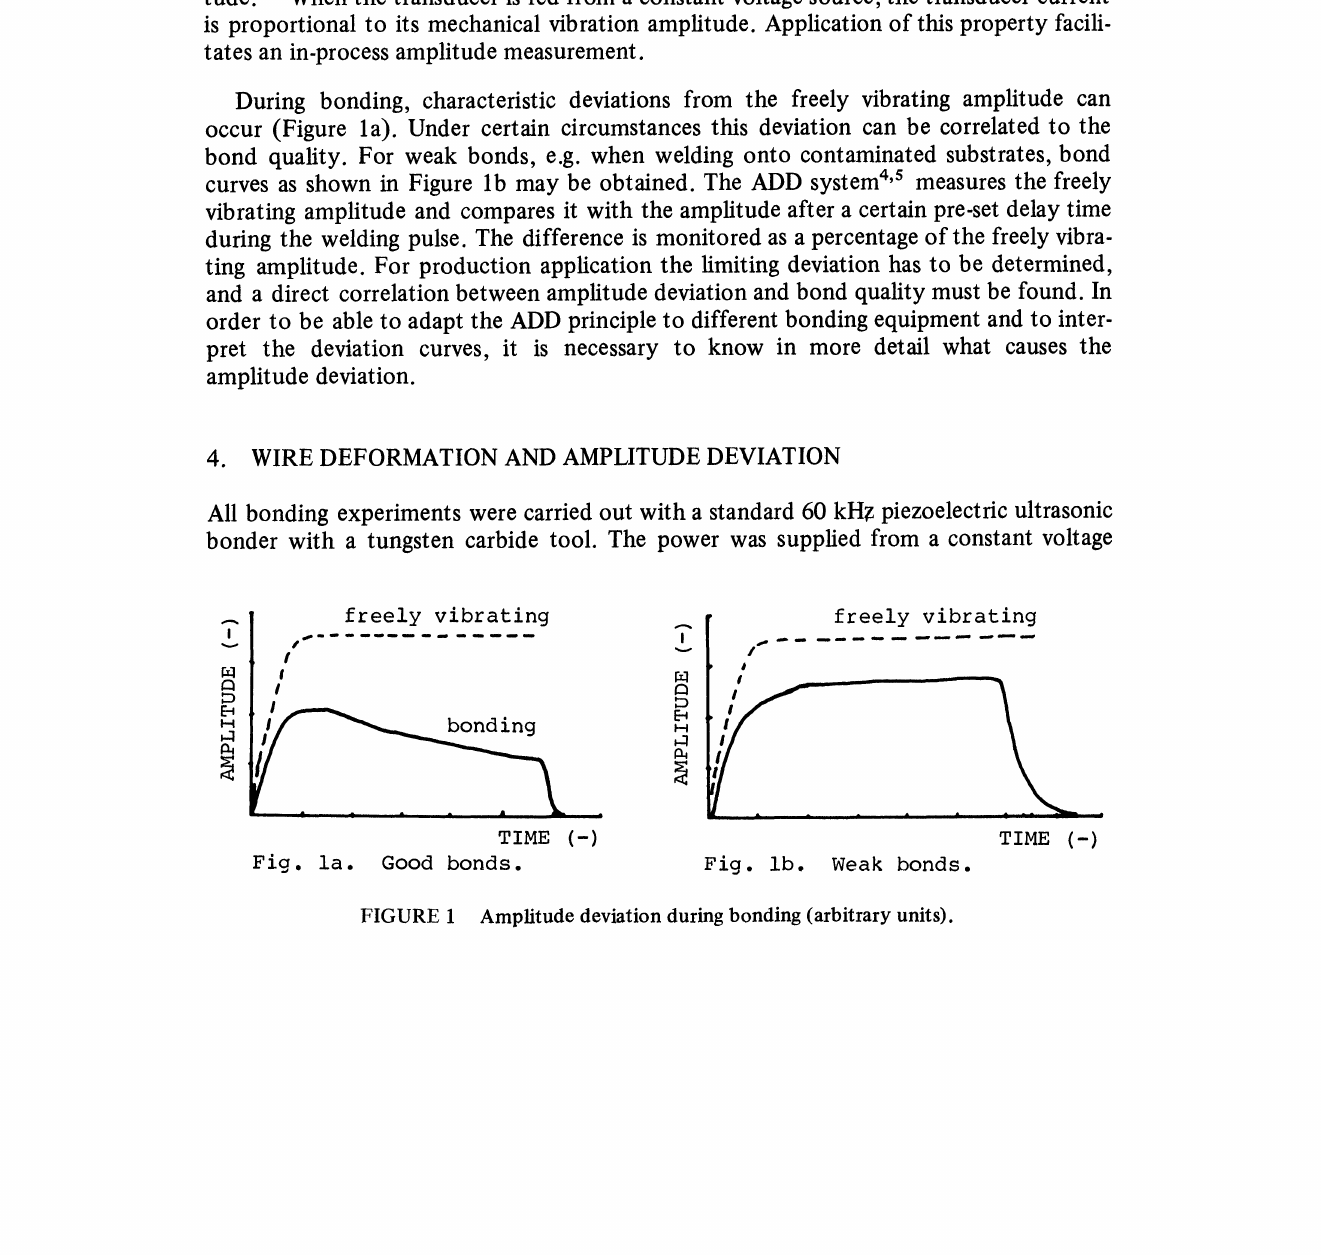
Fig. lb. Weak bonds. FIGURE Amplitude deviation during bonding (arbitrary